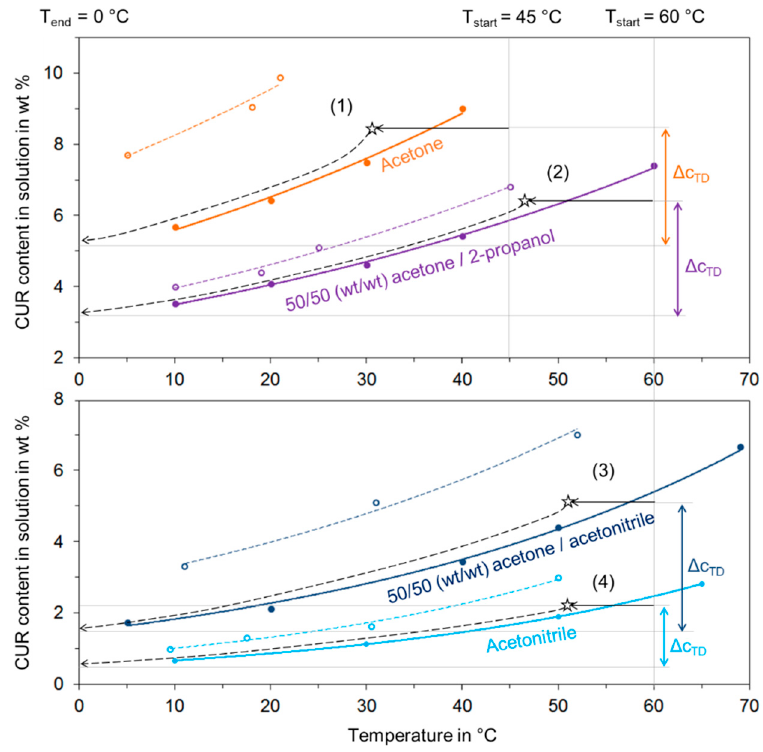
Figure 7. Design of the seeded cooling crystallization processes of CUR based on the solubility curves of CUR in presence of the main impurities (solid lines) and the nucleation border of pure CUR (dashed lines) in acetone (1), 50 / 50 acetone / 2-propanol (2), 50 / 50 acetone / acetonitrile (3) and acetonitrile (4). Black solid / dashed lines with arrows are imaginary curves representing the variation of the CUR concentration during the crystallization process. (T start / T end : start / end temperature of the cooling step; stars: temperature of seed addition; ∆ c TD : maximal depletion of CUR from solution). Table 4. Overview of the selected crystallization process parameters.